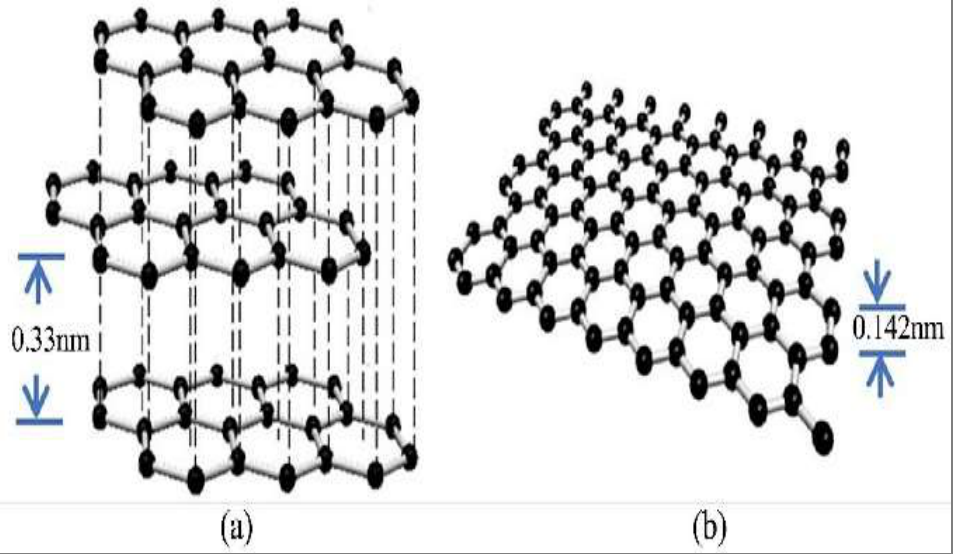
Figure 8: Schematic diagram of (a) Graphite and (b) Single layer of graphene from graphite [93]. Song et al. [94] investigated the adsorption of dibenzothiophene (DBT) on the graphene that is generated